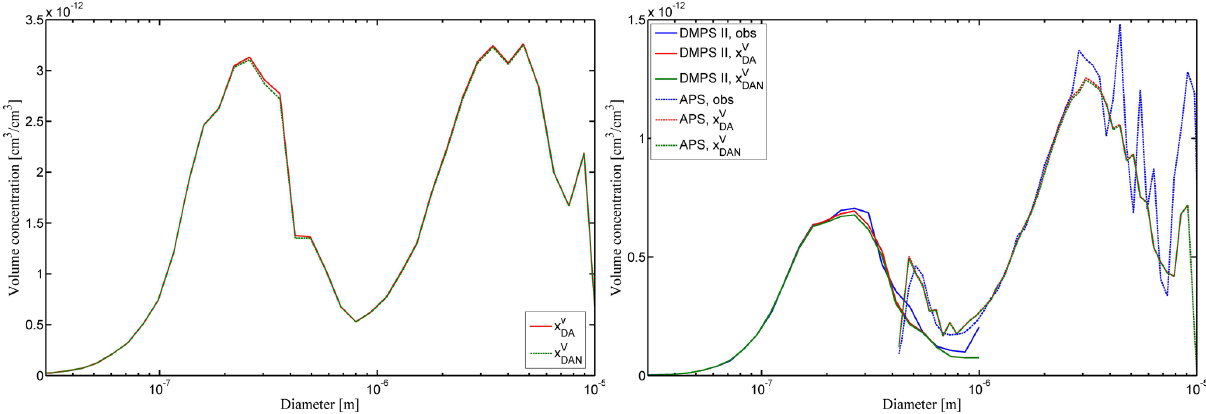
Fig. 6a. (Above) The estimated volume concentration size distribution and (Below) the observations (blue), x V both DMPS II (solid) and APS (dashed) for particle sizes 300nm–10µm from 16:00 on 7 May 2010 from SMEAR II in Hyyti¨al¨a, Finland. Volume concentrations are on the y-axis [cm 3 cm − 3 ] and particle diameter on the x-axis [m].